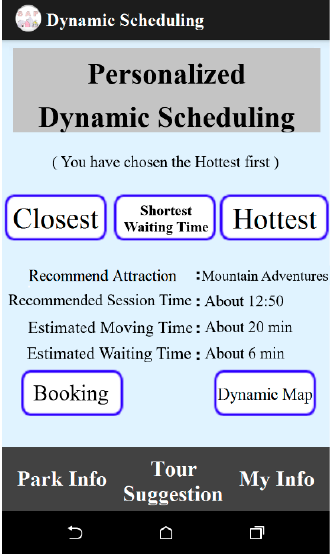
Figure 10. Experimental results for case (cid:1846) (cid:1861)(cid:1827)(cid:1870)(cid:1870) > (cid:1846) (cid:1861)(cid:1835)(cid:1856)(cid:1857)(cid:1853)(cid:1864) .